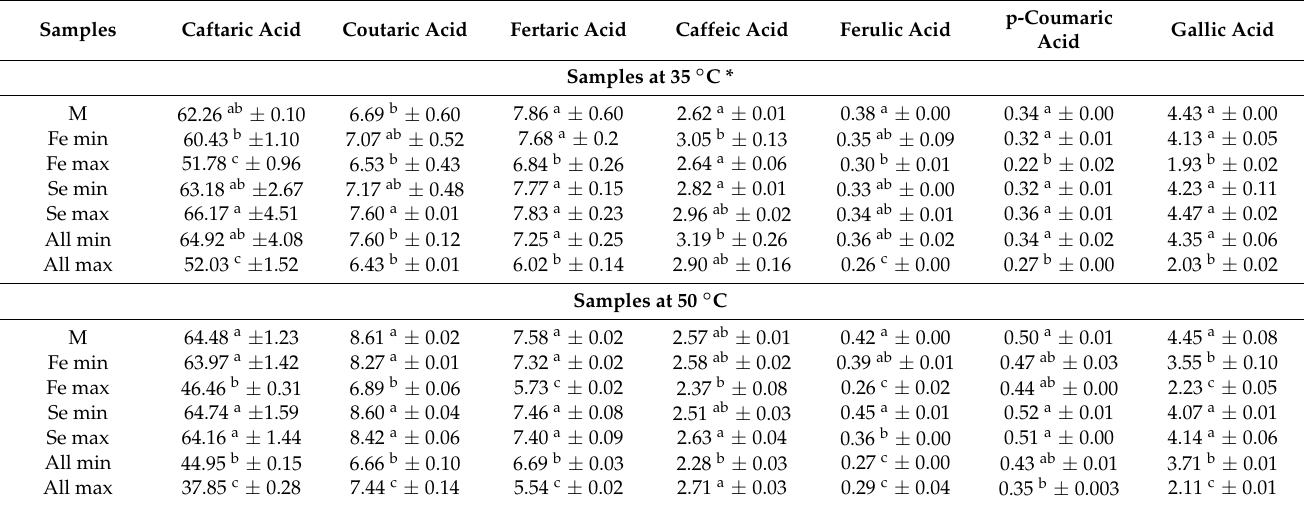
Table 4. Change of caftraric, coutaric, fertaric, caffeic, ferulic, and p-coumaric concentrations * (mg/L) of the samples during 12 days of heating at 35 and 50 ◦